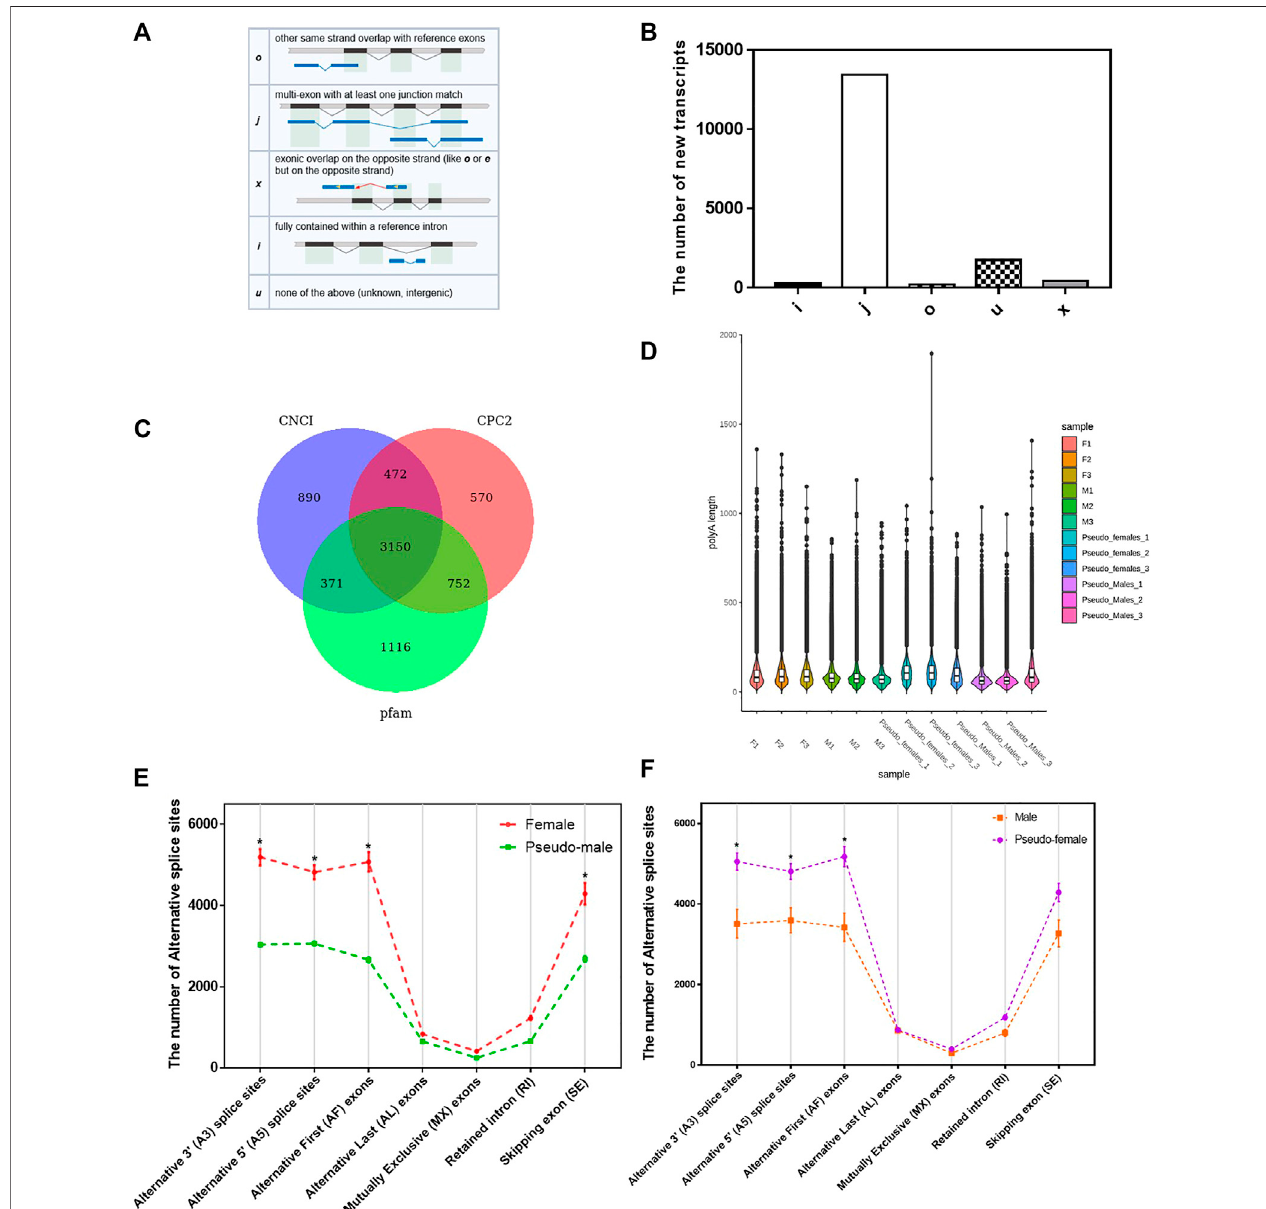
FIGURE 2 | Structure analysis of P. sinensis genders. (A) The structure of 5 new transcripts types. (B) The number of 5 new transcripts types. (C) The Wayne analysis of the number of long noncoding RNA transcripts identi fi ed by three software (CNC1, CPC2, and Pfam). (D) The distribution of the length of ploy(A) tails of different samples. (E) The number of alternative splice sites of females and pseudo-males. (F) The number of alternative splice sites of males and pseudo-females. Data were expressed as mean ± SD. * p < 0.05.